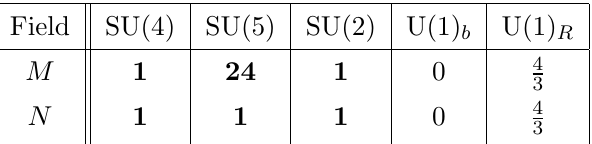
Table 2 . The charges of the (cid:13)ip (cid:12)elds under the global